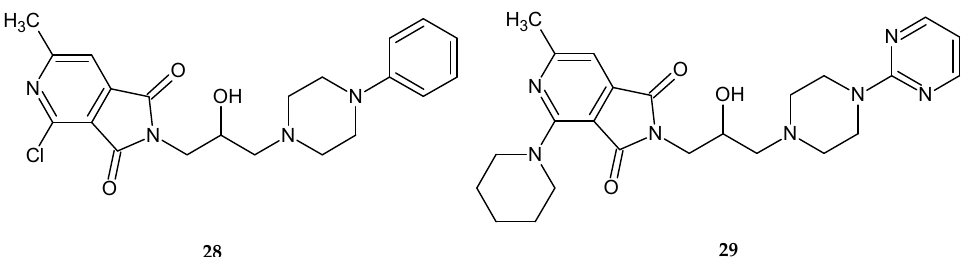
Figure 23. Pyrrolo[3,4 ‐ c ]pyridines 28 and 29 significantly inhibited the spontaneous locomotor activity in mice.